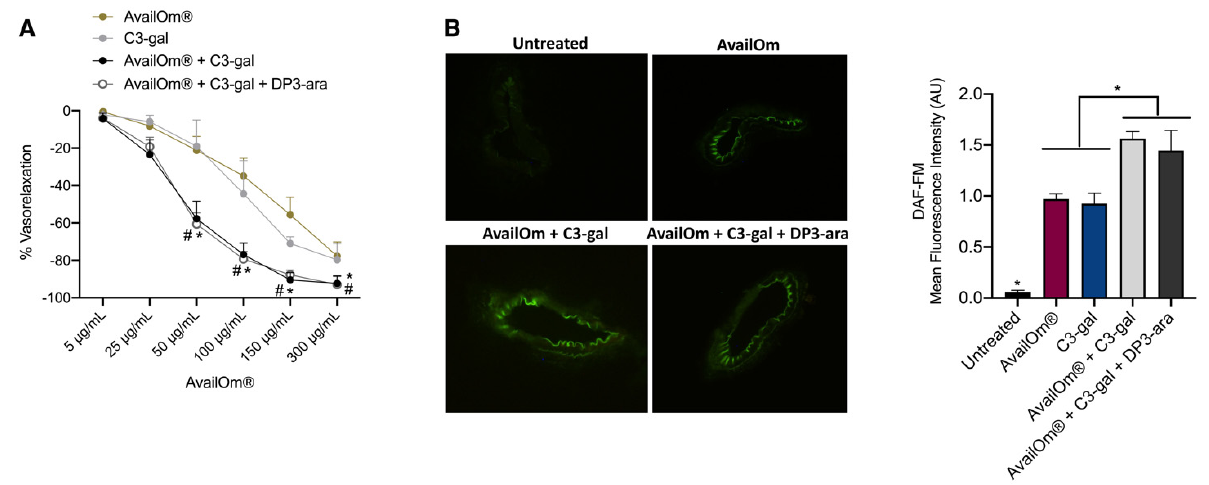
Figure 4. Effect of AvailOm ® in combination with different anthocyanins on vascular function and nitric oxide production. ( A ) Vascular response of phenylephrine-precontracted mice vessels to increasing doses of AvailOm ® (5–150 µg/mL) or to C3-gal, or to AvalOm ® plus C3-gal or AvalOm ® plus C3-gal plus DP3-ara with a ratio ½:½ or 1/3 respectively (N = 3). ( B ) Representative high-power micrographs of mice mesenteric arteries cryosections loaded for 2 h with 4,5-diaminofluorescein (DAF-FM) after treatment with AvailOm ® or single combination bar graph shows the mean fluorescence intensity of section for each compound (N = 4). * p < 0.05 AvailOm ® + C3-gal vs. AvailOm ® alone; # p < 0.05 AvailOm ® + C3-gal + DP3-ara vs. AvailOm ® alone.